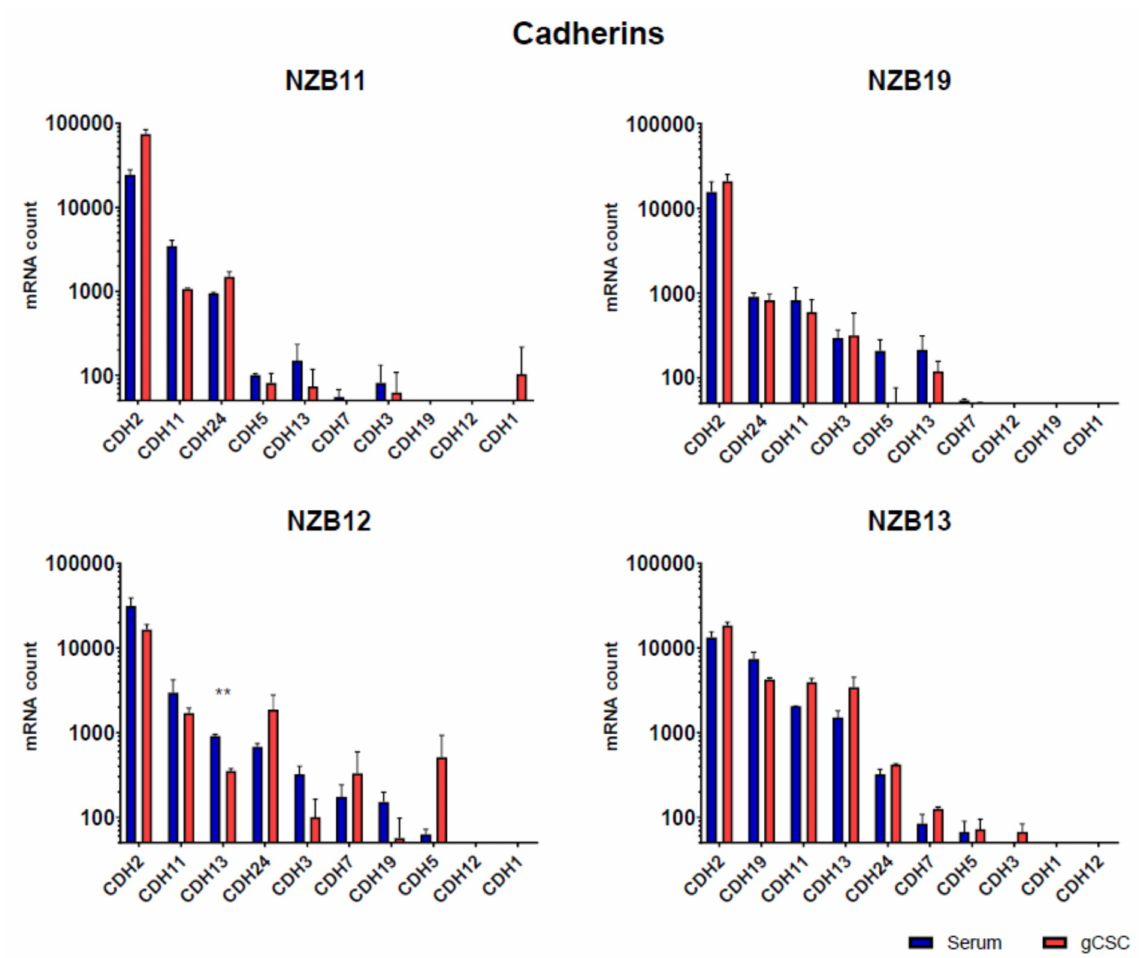
Figure 9. Cadherin gene expression by glioblastoma cells. NanoString TM analysis of absolute mRNA counts in NZB11, NZB19, NZB12, and NZB13 serum-derived and gCSC GBM lines. The results of two independent experiments are shown. Unpaired students t-test analysis was carried out comparing the serum vs gCSC mRNA count for each gene where p -value ≤ 0.05 (*) and 0.01